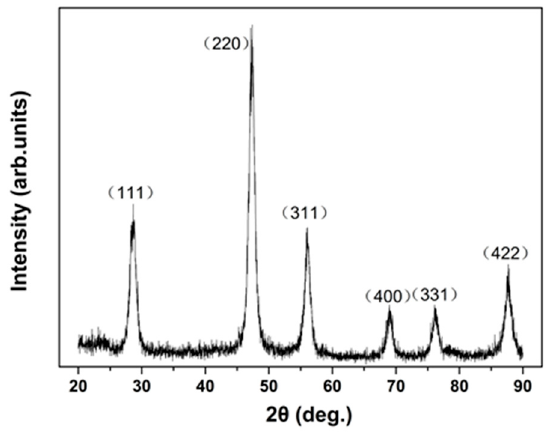
Figure 3. The X-ray diffraction pattern of CaF 2 nanoparticles with 3 mol% Tb concentrations at atmospheric pressure.